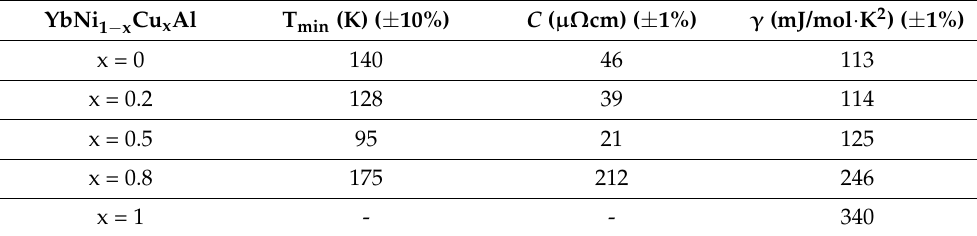
Table 3. Dependence on the Cu concentration (x) of some parameters extracted from the electrical resistivity and specific heat results in the series of YbNi 1 − x Cu x Al